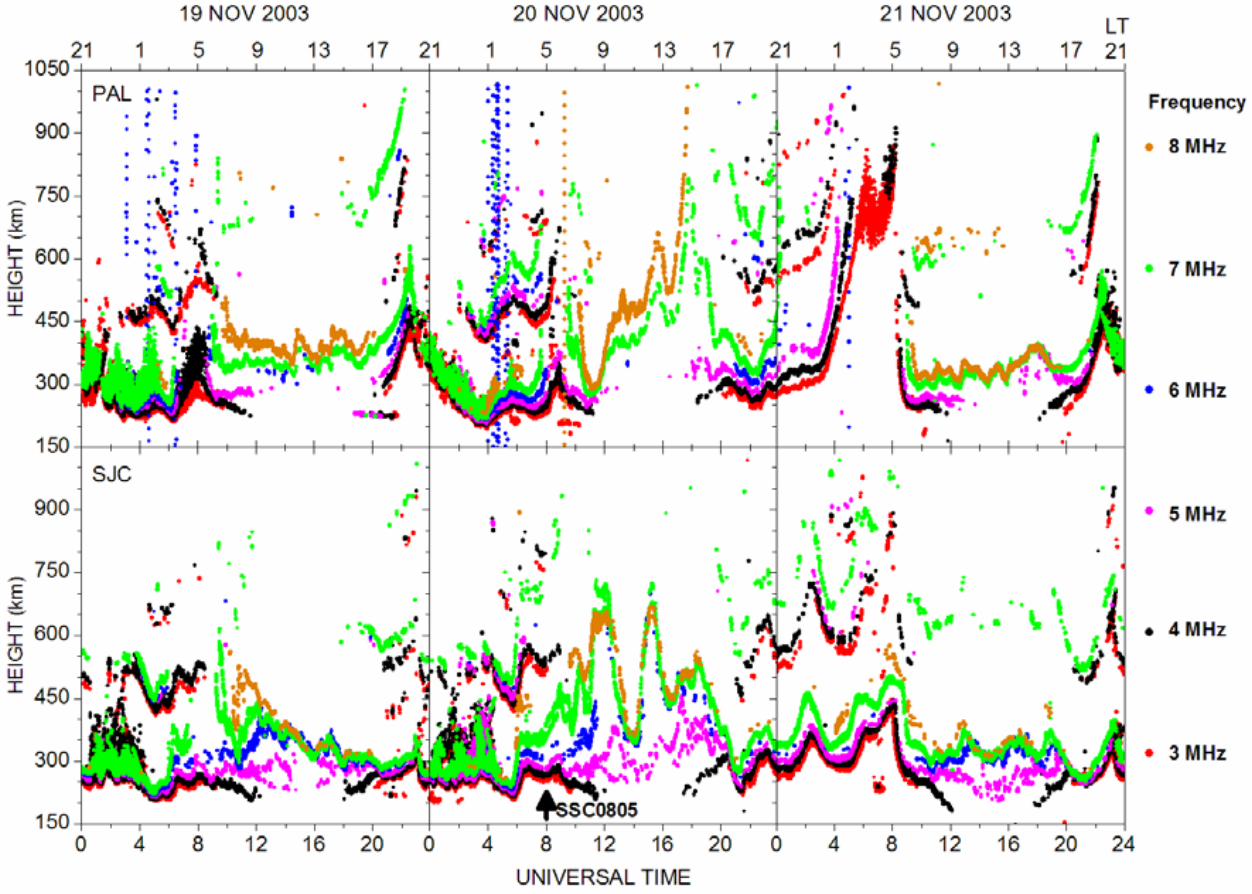
Fig. 6. Virtual height variation plots for different fixed frequencies (iso-frequencies) for the period 19 to 21 November, 2003, observed at PAL (top) and SJC